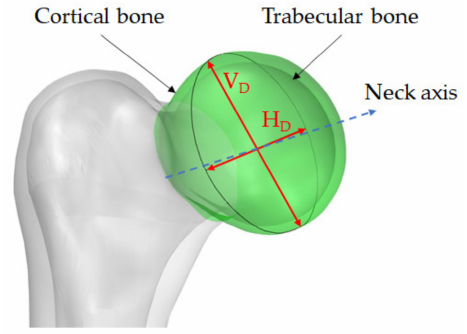
Figure 3. Horizontal (H D ) and vertical (V D ) diameters of a femoral